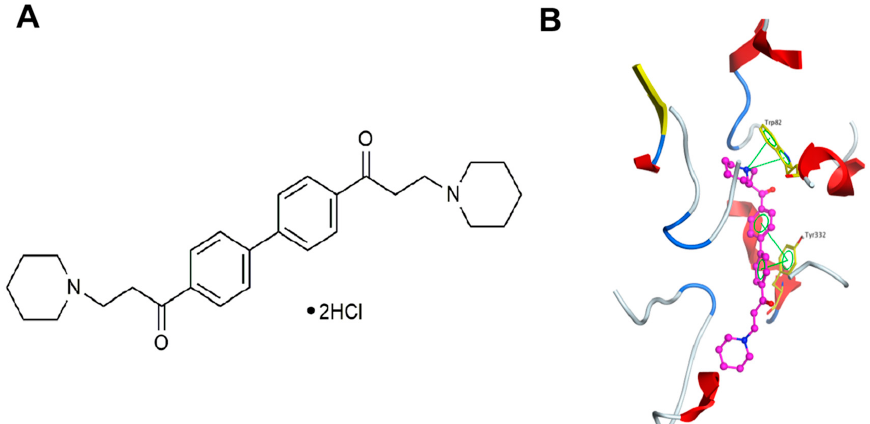
Figure 1. The chemical structure of DL0410 ( A ) and DL0410 in the active site of butyrylcholinestease (BuChE) (PDBID: 4BDS). DL0410 is displayed in the ball-stick model with carbon in purple, and the binding residues are shown in the stick model with carbon in yellow ( B ). Nitrogen is shown in blue and oxygen is in red.